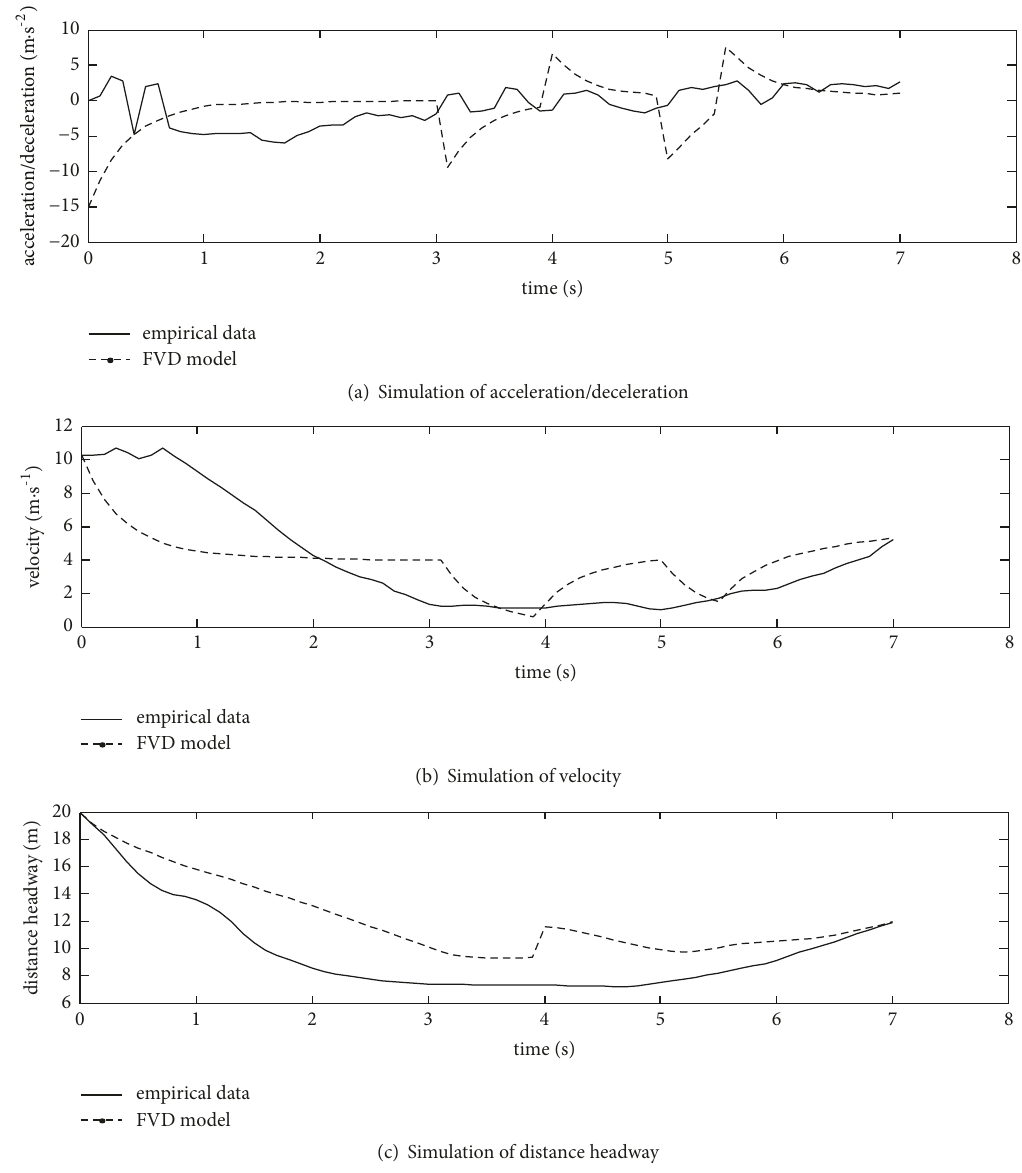
Figure 7: FVD model simulation of car-following Process